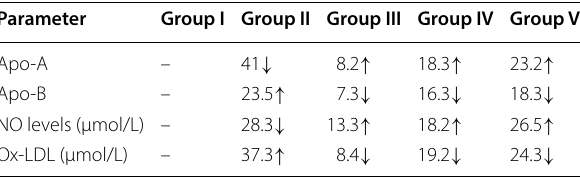
Table 3 Protective effect of T. portulacastrum extract on endothelial dysfunction streptozotocin induced diabetic rats